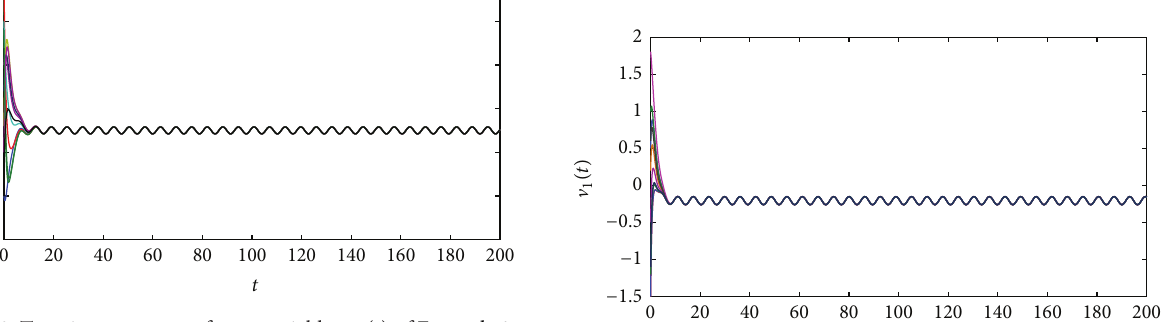
Figure 8: Transient response of state variables 𝑢 2 (𝑡) of Example 2.